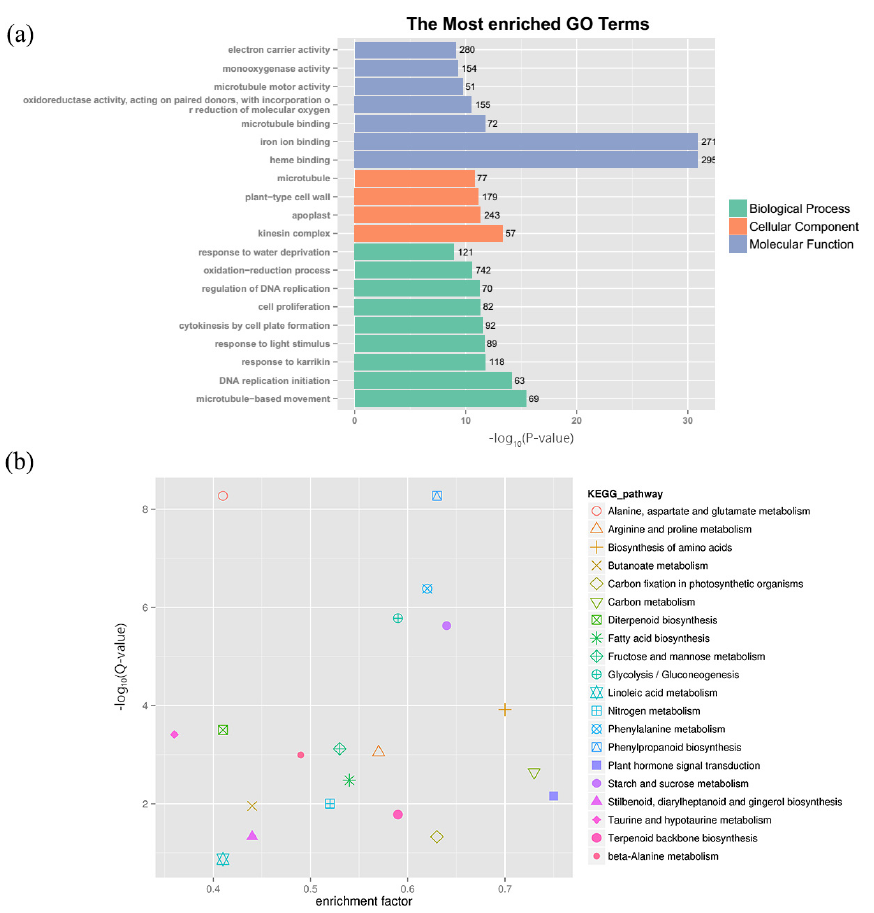
Figure 3. GO enrichment and KEGG enrichment of DEGs (Y9_CK3 vs. Y9_NA3). ( a ) Top 20 GO term DEGs were enriched in three main categories: “biological process”, “cellular component”, and “molecular function”. ( b ) KEGG enrichment of DEGs. The horizontal axis represents enrichment factor, and the vertical axis represents Q-value. Different markers represent different pathways.